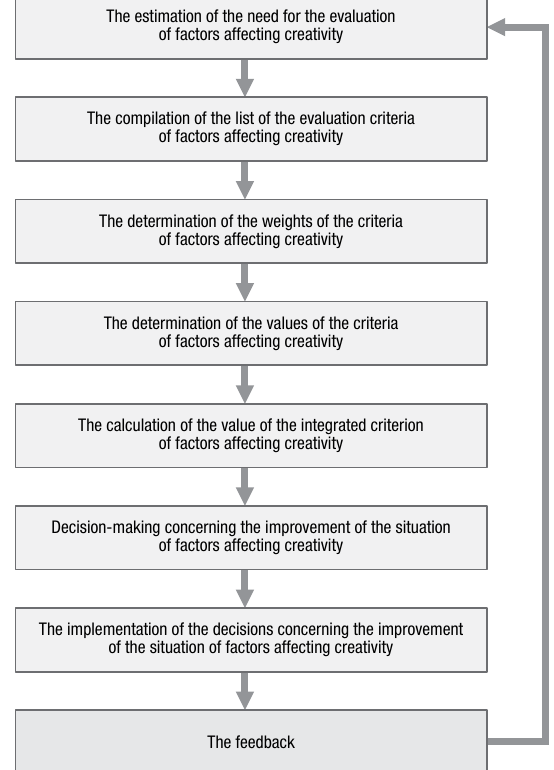
Fig. 1. The sequence of the evaluation of factors affecting